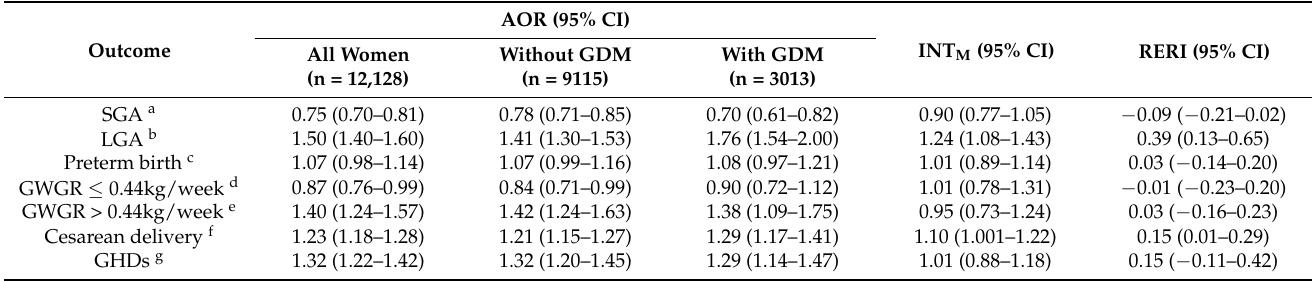
Table 2. Modifying effect of GDM on association of total GWGR with perinatal